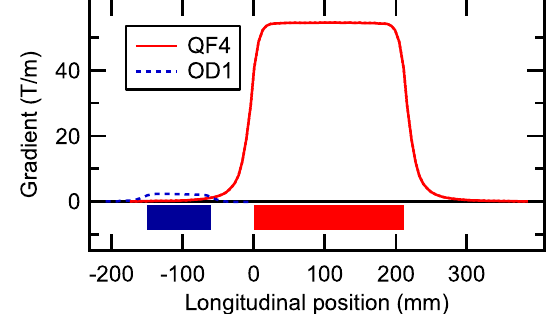
TABLE VII. Measured and simulated value of the integrated